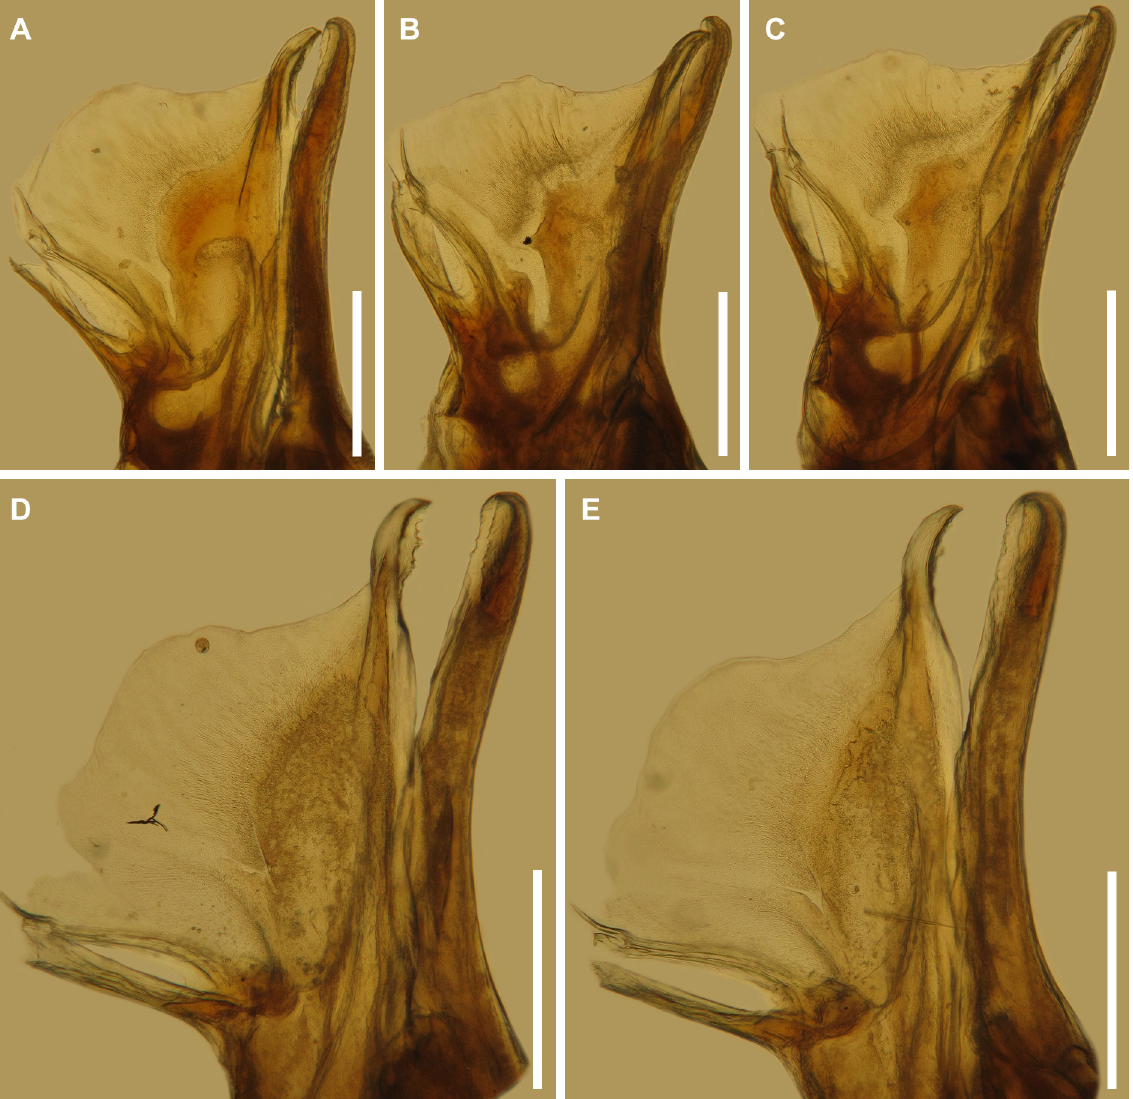
Fig. 13. Leucogeorgia rediviva Golovatch, 1983, gonopods. A . ♂ from Khabyu Cave, right gonopods, mesal view (SMNG). B . ♂ from Novoafonskaya Cave, left gonopods, lateral view (ZMUM). C . ♂ from Novoafonskaya Cave, right gonopods, mesal view (ZMUM). D . ♂ from Snezhnaya Cave, left gonopods, lateral view (ZMUM). E . ♂ from Snezhnaya Cave, right gonopods, mesal view (ZMUM). Scale bars: 0.3